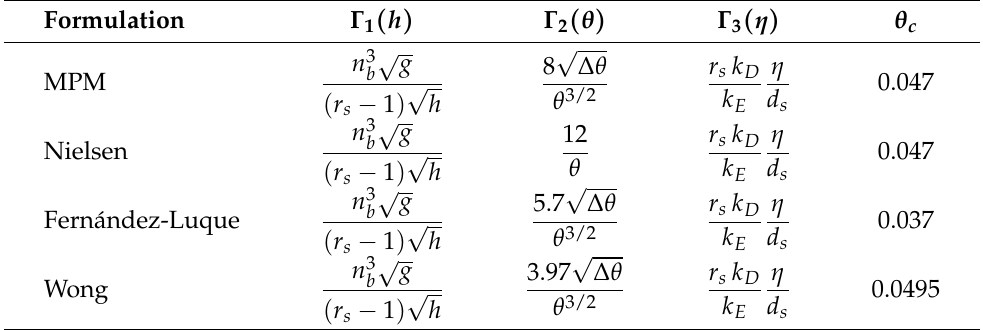
Table 2. Noncapacity Grass interaction factor G for different solid transport rate